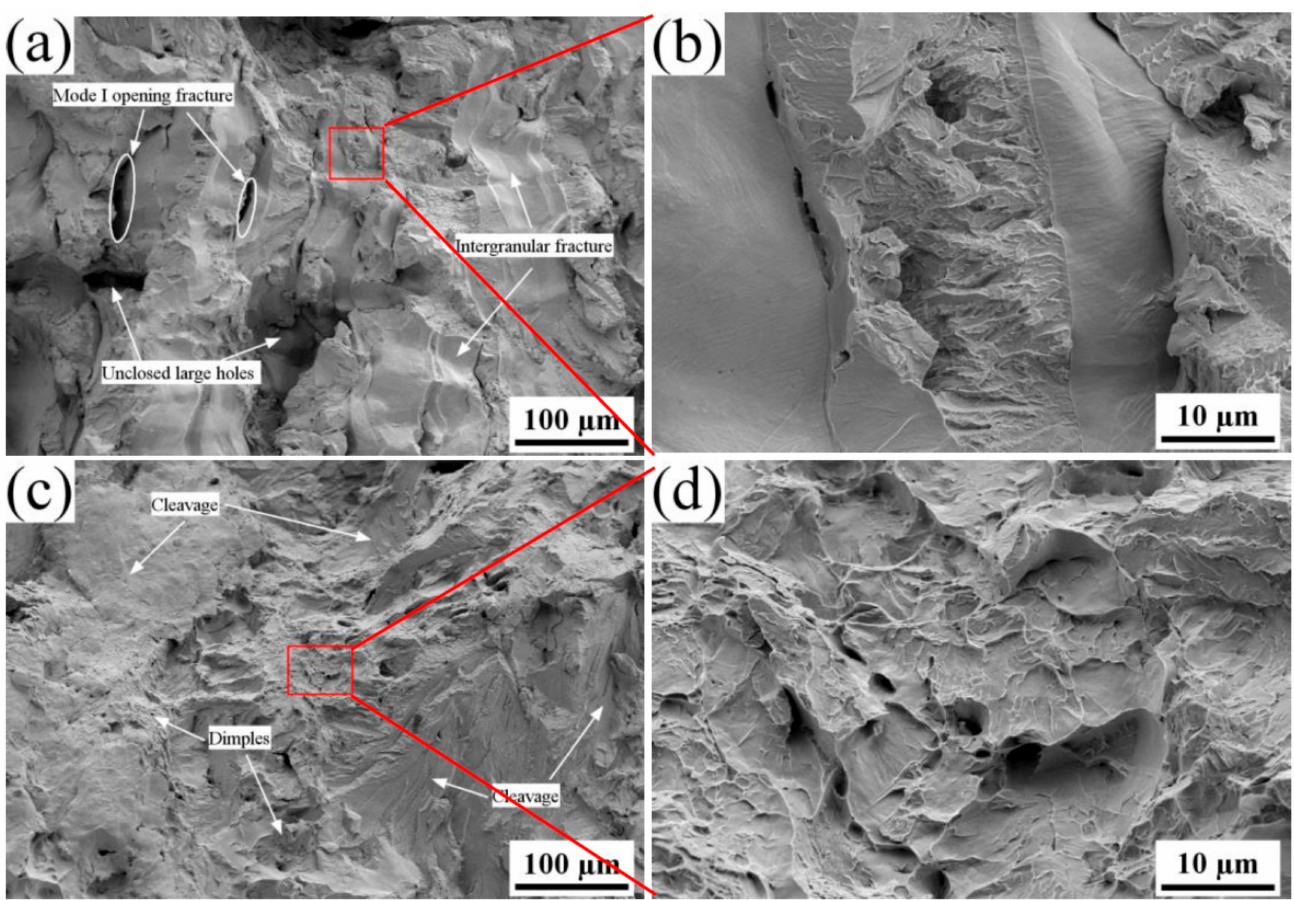
Figure 8. Fracture morphologies of SLMed Ta manufactured at different energy densities: ( a , b ) 342 J/mm 3 and ( c , d ) 190 J/mm 3